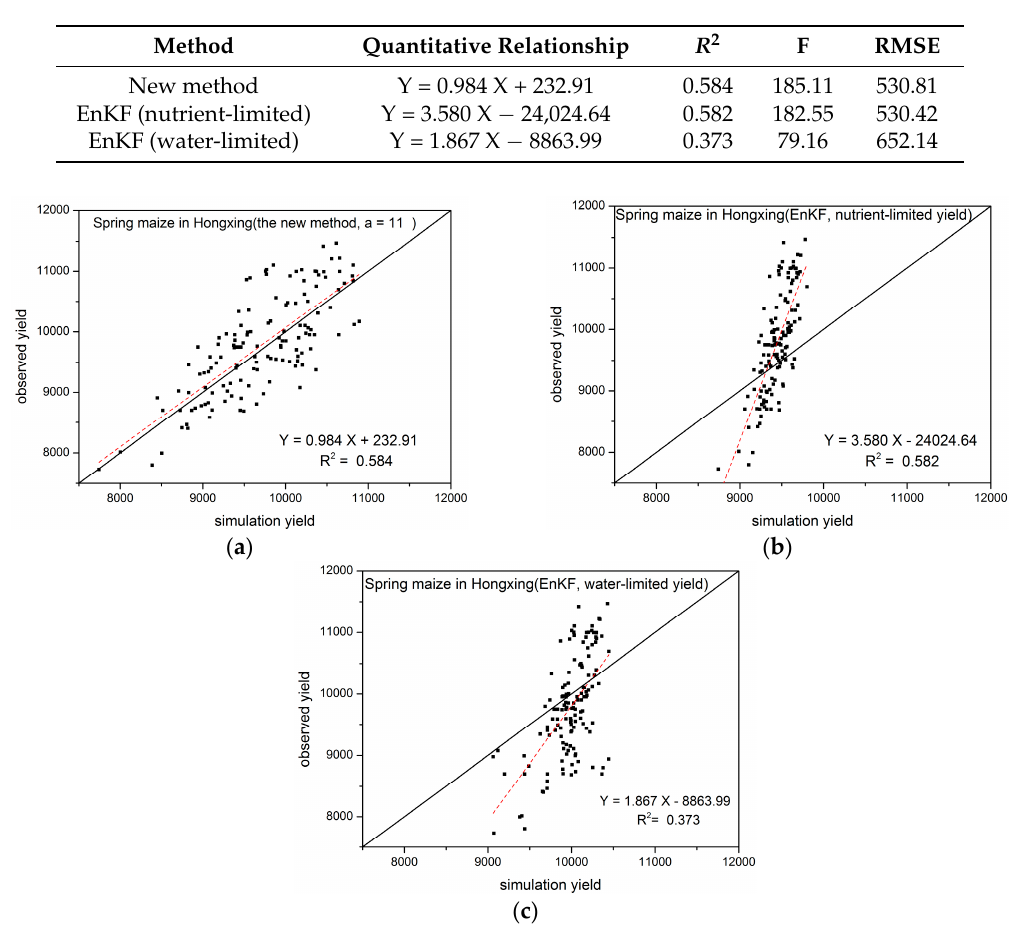
Figure 7. Analysis results of the yields of Hongxing in 2014: ( a ) the new method ( a = 11), ( b ) EnKF method (nutrient-limited yield), ( c ) EnKF method (water-limited yield). method (nutrient-limited yield); ( c ) EnKF method (water-limited